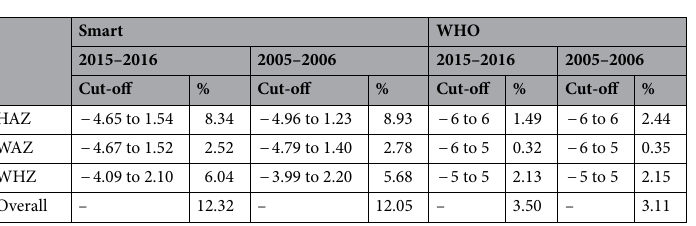
Table 1. Cut-off values for acceptance for SMART and WHO flags and percentage of excluded observations.